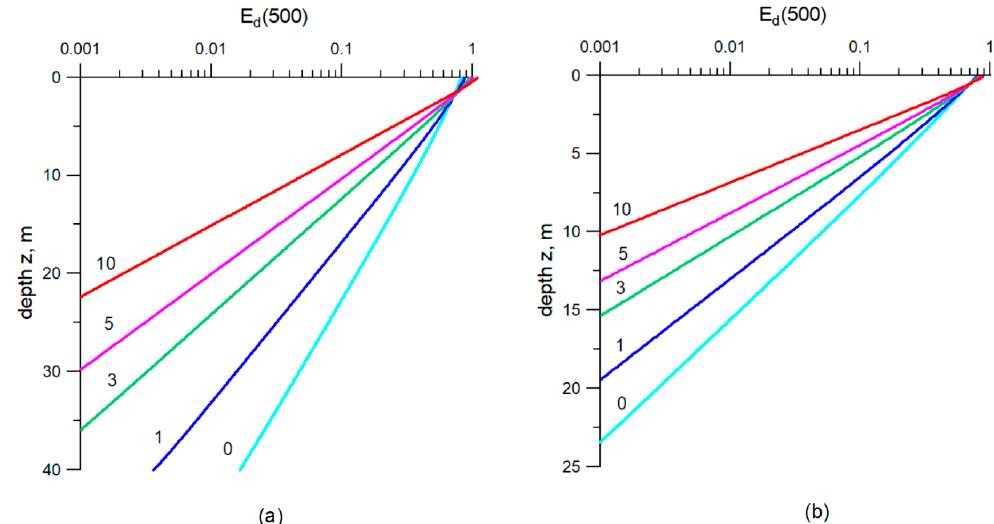
Figure 10. The downward irradiance profiles calculated for the case of the Black Sea, λ = 500 nm and θ 0 = 25°, depending on the coccolithophore concentration N coc for the absorption coefficient a (440) = 0.09 m − 1 ( a ) and 0.53 m − 1 ( b ). The numbers near the curves indicate the N coc , 10 6 cell/L values. Table 5. The depth of the photic layer Z 1% (m) for λ = 500 nm, in the cases of the Black Sea and Barents Sea, depending on the value of N coc , the illumination conditions, and the absorption coefficient.